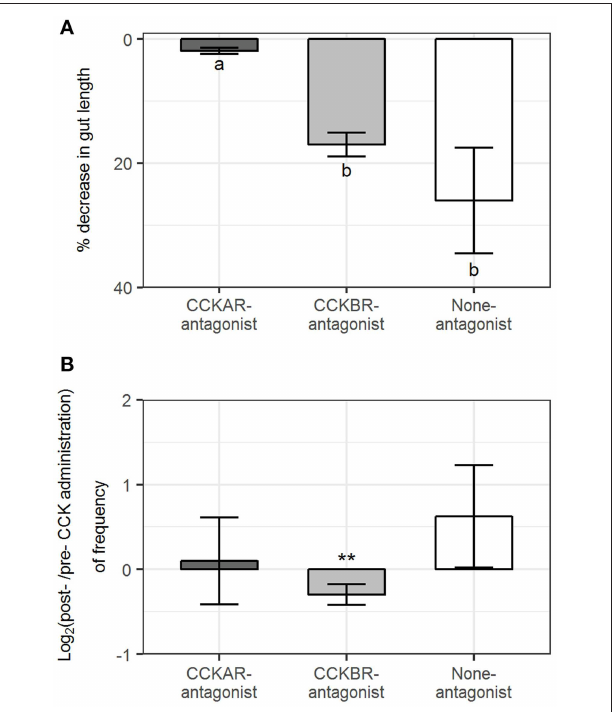
FIGURE 12 | Effect of CCK-8S with presence of CCK-receptor antagonists on longitudinal contractions. CCKAR-antagonist: intestines were pre-incubated with devazepide, CCKBR-antagonist: intestines were pre-incubated with L-365260, and none-antagonist: intestines were pre-incubated with DMSO as a control prior to exposing intestine to CCK-8S. (A) decrease in length of intestine after being exposed to CCK-8S and (B) log 2 (ratio) of frequency of events for intestinal length reduction on intestine after to before being exposed to CCK-8S. Bars are presented with mean ± SEM ( n = 4 for CCKAR-antagonist, n = 5 for each CCKBR-antagonist/none-antagonist). Different letters indicate statistically significant differences ( p < 0.05; ANOVA, Tukey post-hoc test) among three treatments (CCKAR-antagonist, CCKBR-antagonist and none-antagonist) in (A) . *Statistically significant differences of log 2 (ratio) values compared with 0 (one sample t -test, *for 0.05 ≤ p < 0.1 and **for p < 0.05) in (B)